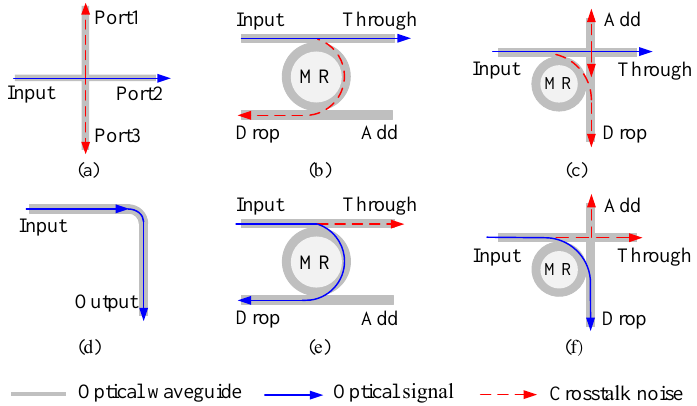
Figure 1. ( a ) Waveguide crossing; ( b ) Parallel switching element (PSE) in OFF state; ( c ) Crossing switching element (CSE) in OFF state; ( d ) Waveguide bend; ( e ) PSE in ON state; ( f ) CSE in ON